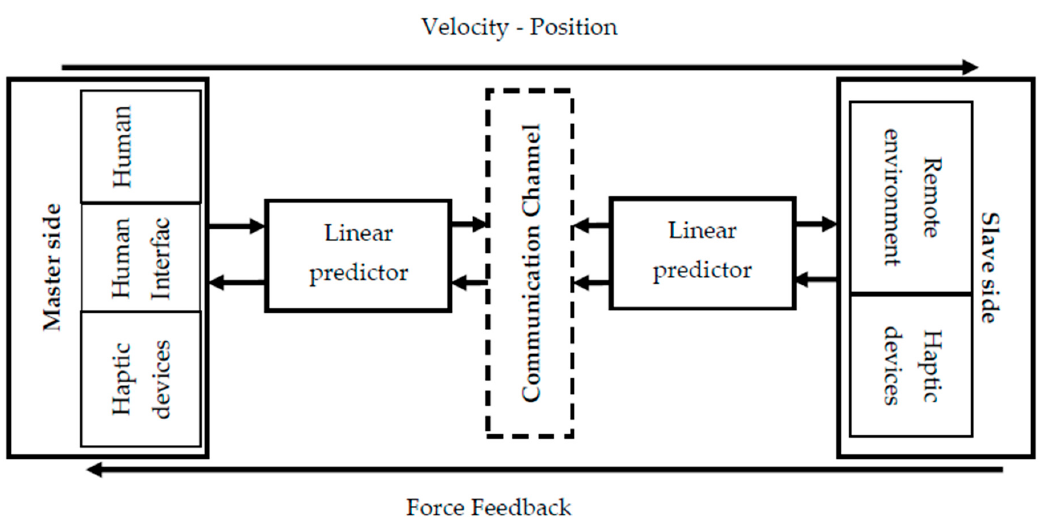
Figure 6. System structure of the model mediated bilateral teleoperated system with two coherent linear predictors developed in [71].